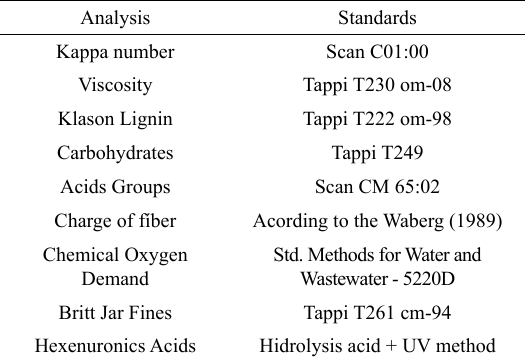
Table 1. Analytical procedures and its respective technical standards.